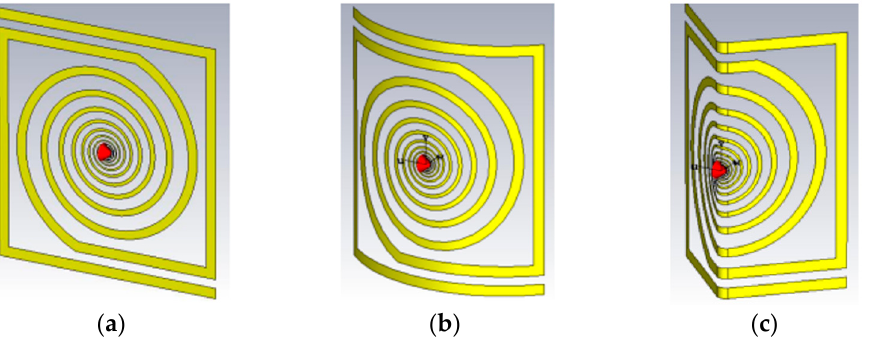
Figure 3. RFID antenna design in con fi guration: ( a ) planar, ( b ) curved at an angle of 90°, and ( c ) bent at an angle of 90°.